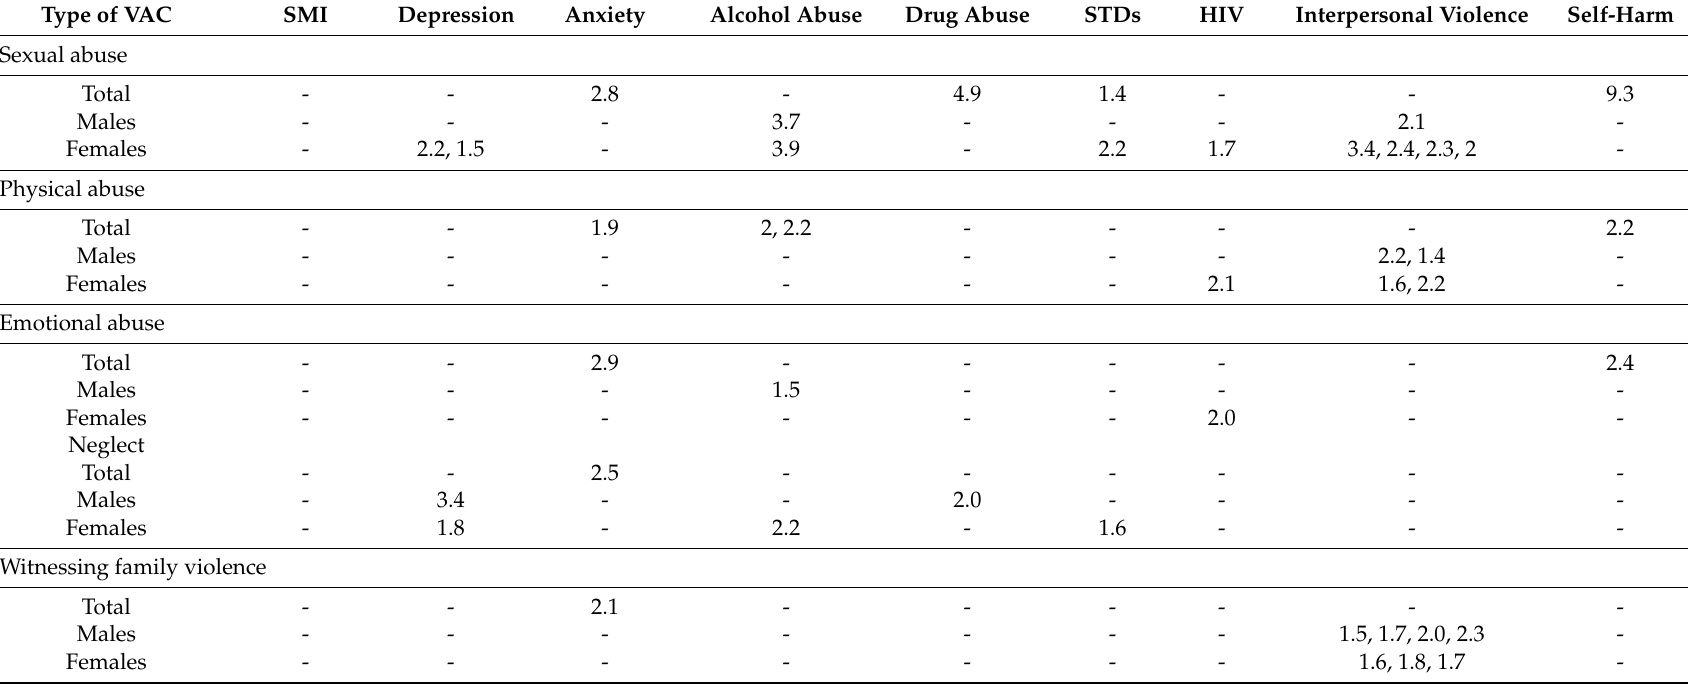
Table A2. Odd ratios (ORs) for health outcomes associated with childhood violence based on the systematic review.